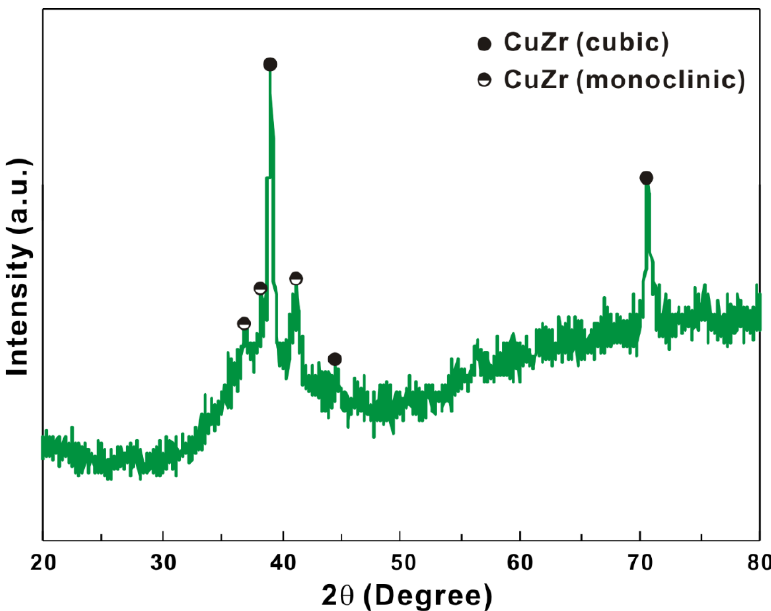
Figure 5. XRD patterns of the as-deformed Cu 45 Zr 45 Zn 10 rods.